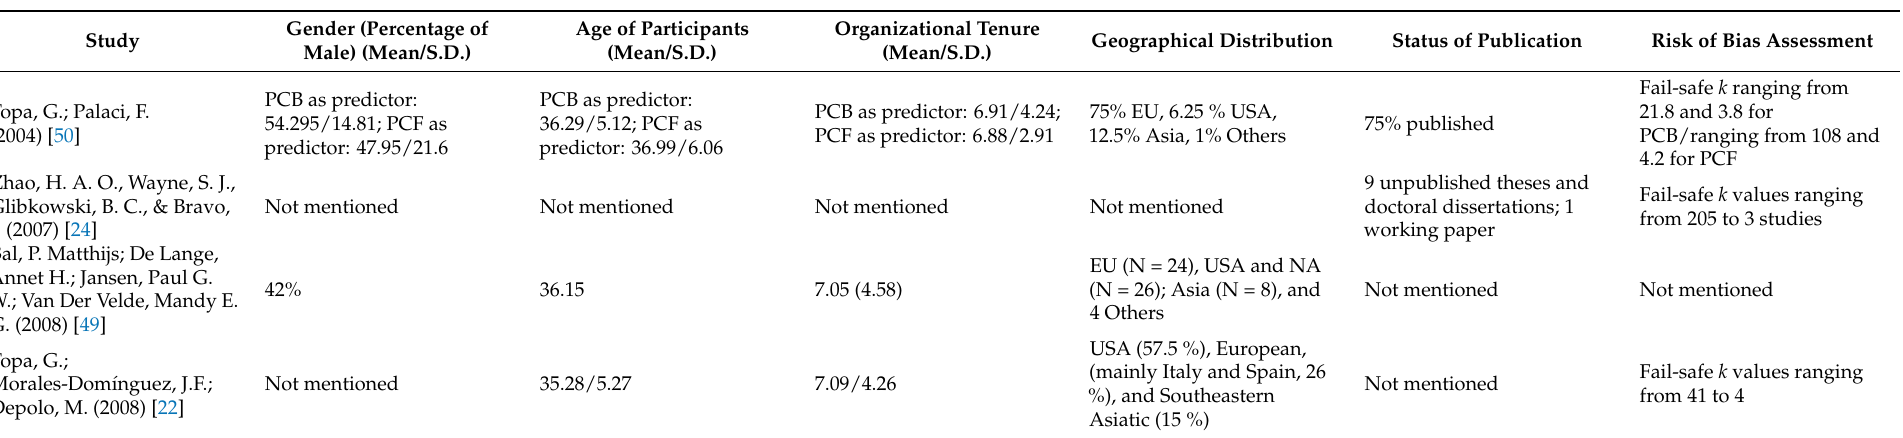
Table 3. Participant characteristics of the included reviews and